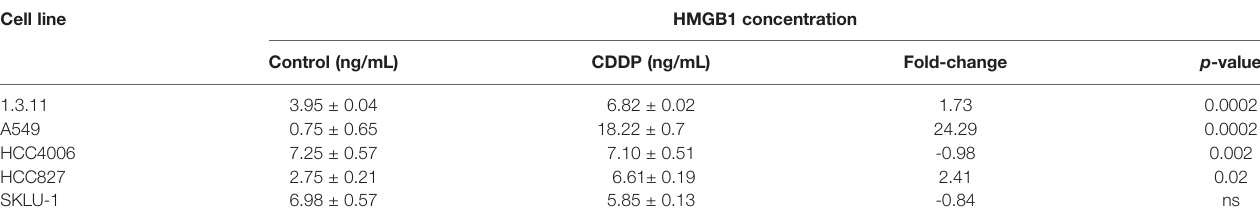
ns, non-signi fi